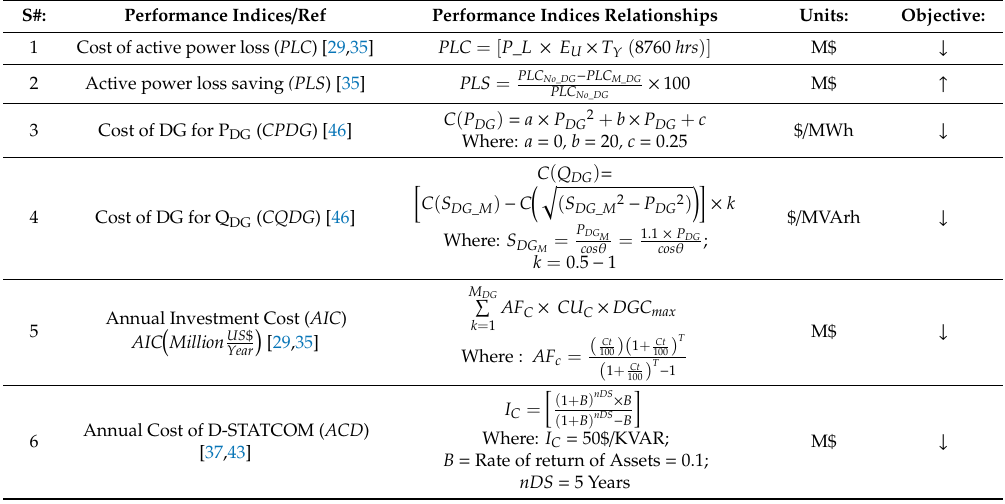
Table 2. Cost-economic-based performance indices (designated in this paper as CPIs or